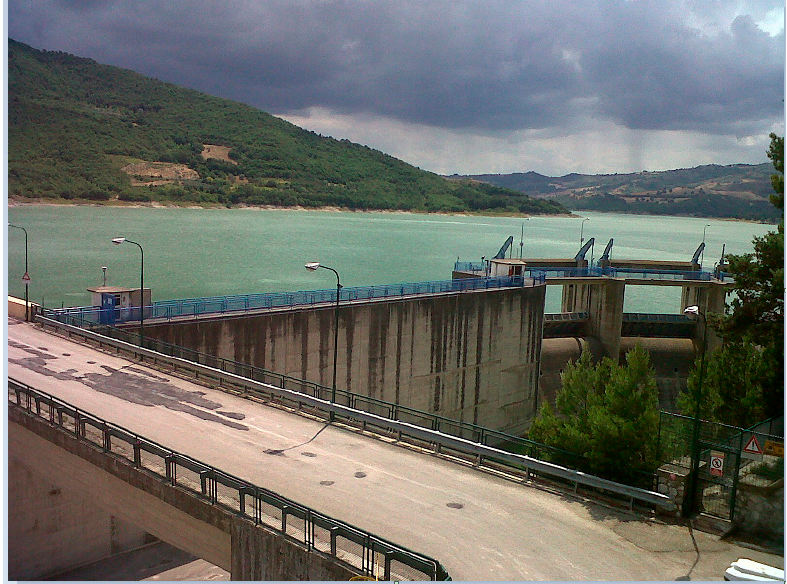
Figure 13. Occhito dam, Carlantino. Monitoring of the footbridge.